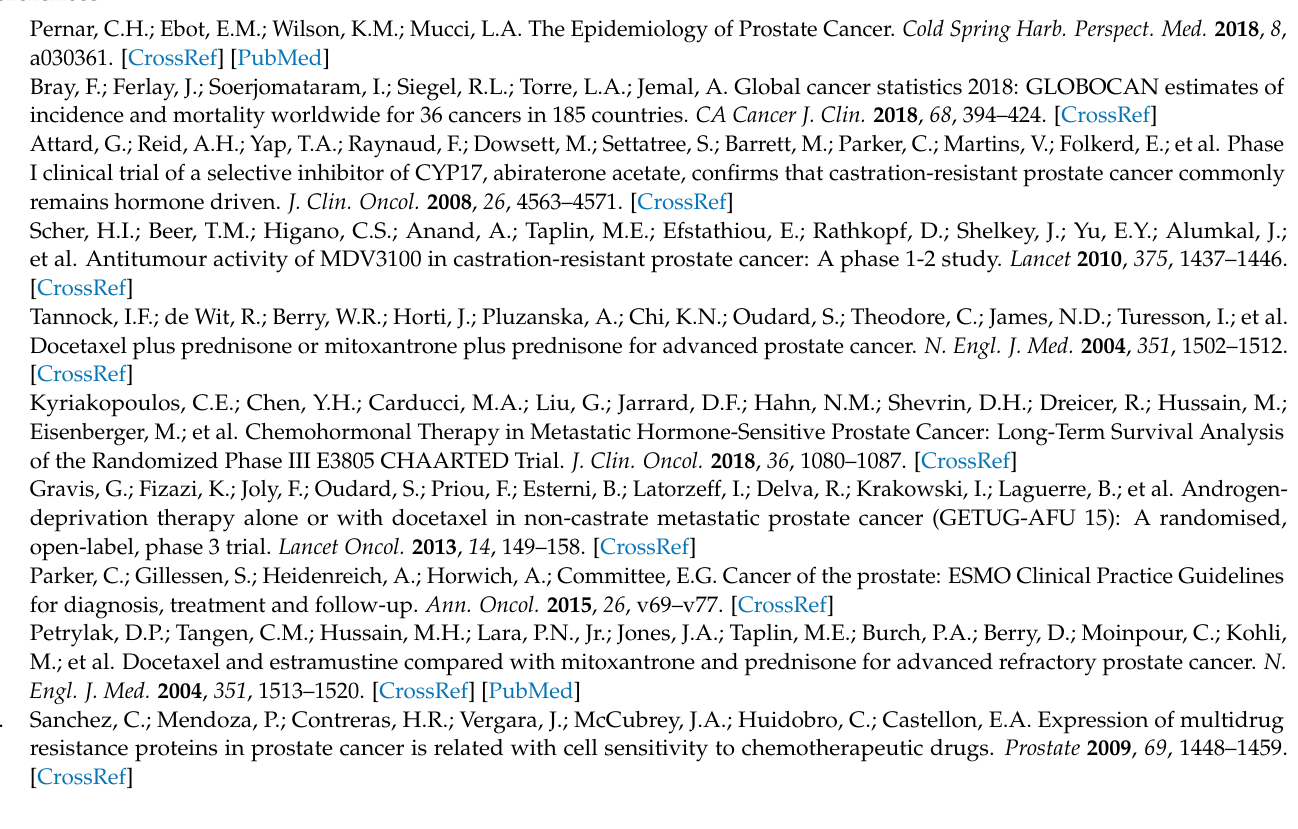
Blot from Figure 6a, Figure S3: Uncropped Western Blot from Figure 6d, Table S1: Significantly deregulated genes found in docetaxel-resistant C4-2B R cells compared to matched parental C4-2B cells, Table S2: Significantly deregulated genes found in docetaxel-resistant LNCaP R cells compared to the matched parental LNCaP cell